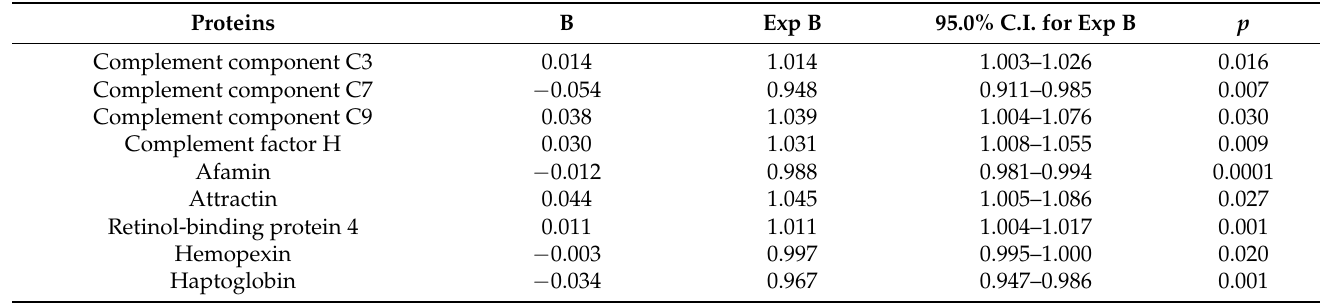
Table 2. Results of multivariate regression analysis of the association of proteins with the instability of atherosclerotic plaques (dependent